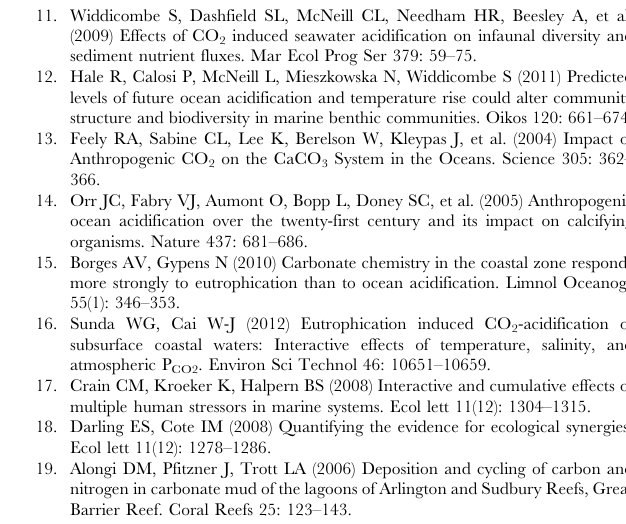
Figure S2 Boxplots showing the variability of the oxygen and nutrient fluxes through the four treatments (Calci- um carbonate, Control, Mix and Organic matter). Gross ganic nitrogen in daylight (DIN light ), nitrate uptake and during daylight (NO 3 2 uptake and NO 3 2 light ), dissolved inorganic carbon during daylight (DIC light ). Units: m mol m 2 2 h 2 1 . Figure S3 Schematic diagram showing the layout of the plots with the treatments (Calcium carbonate, Organic matter, Mix: OM + CC, and Control) across the sampling area in a balanced orthogonal design with randomized interspersed treatment positions (3 blocks). Below a picture showing a diver introducing the treatment inside one of the plots through a syringe activated sampling port. Plots were made of two parts: a square chamber base (aluminum border with sides 50 6 50 cm 6 10 cm tall) pressed down into the sediment ( , 5 cm) and a clear acrylic plastic dome (50 6 50 cm) fitted to the chamber bases and clamped in place. Table S1 Summary of the ANOVAs (Treatment and blocks as fixed factors) for sediment characteristics (chlorophyll a and organic matter), water pH and macrofauna communities (Abundance of large organ- isms, total abundance, number of species and the abundance of deposit and suspension feeders). Treat- ments: OM: Organic matter, CC: Calcium carbonate, Mix: OM + CC, Control. Significant results in italics. Table S2 Summary of the ANOVA outputs from the Generalized Linear Models (Table 1), including Treat- ment and Day (3 sampling days) as fixed factors. Table S3 Generalized Linear Model summary (regres- sion-based models with Gaussian distribution and identity link function) indicating the significance of ammonium uptake (NH 4 + ) on gross primary production